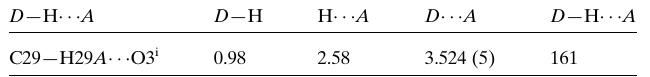
Table 2 Hydrogen-bond geometry (A˚ , (cid:2) ) for (III).